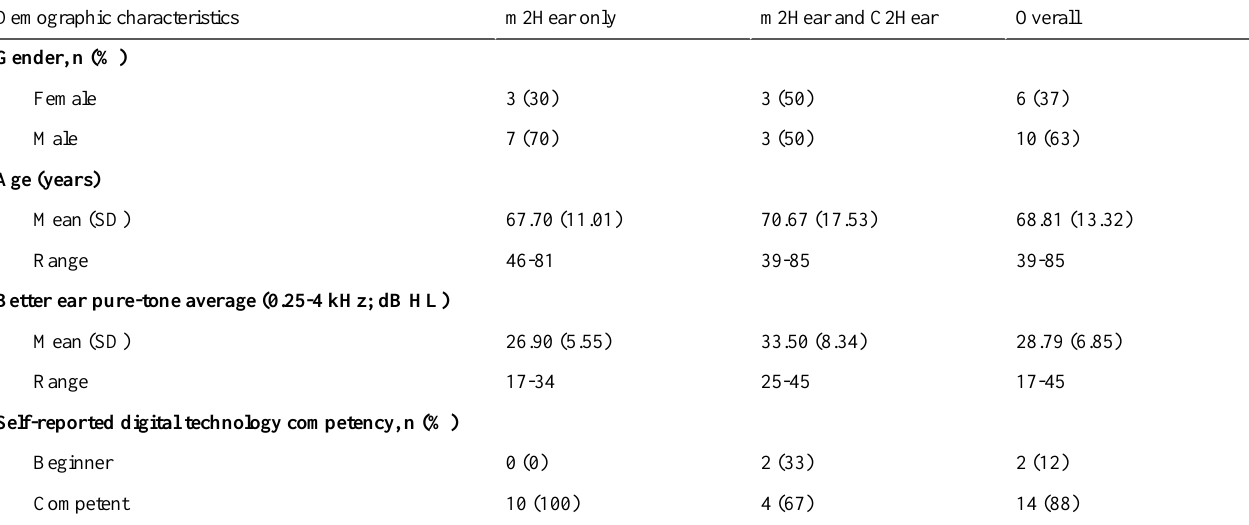
Table 1. Demographic information of participants who trialed either m2Hear alone or both m2Hear and